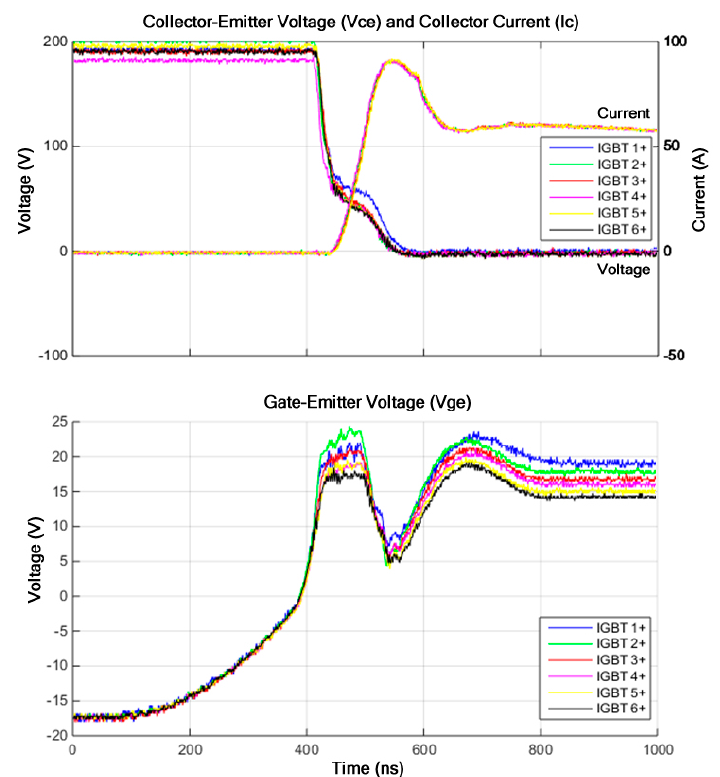
Figure 17. Turn-on switching with 60 A load current, reinforcing the previous result on the increase of the effects of the natural intrinsic balancing with the increase of the collector current.